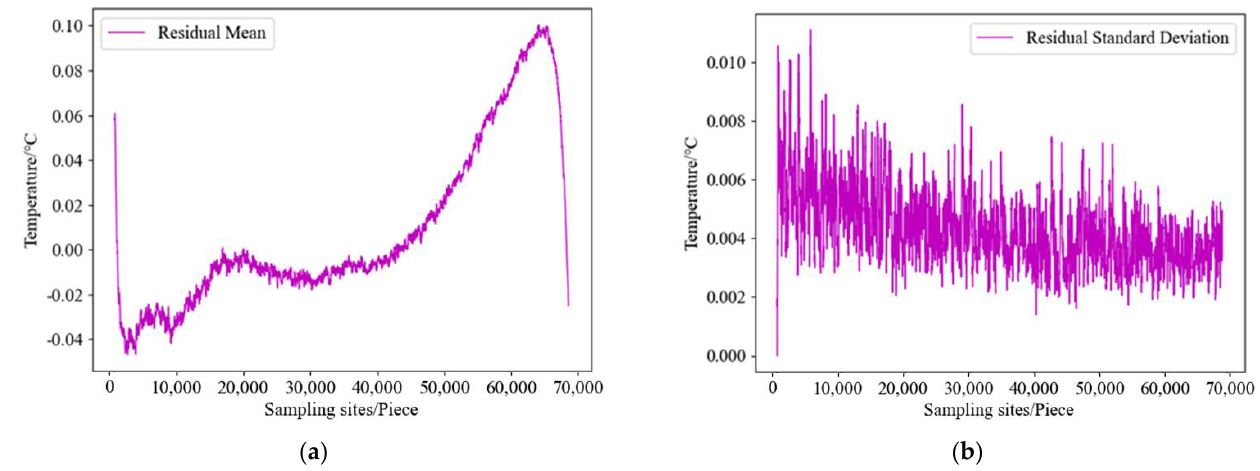
Figure 9. Residual results for training set 1 of the simulation model. ( a ) Residual mean. ( b ) Residual standard deviation. Table 8. Calculated values for detailed pre-alarm